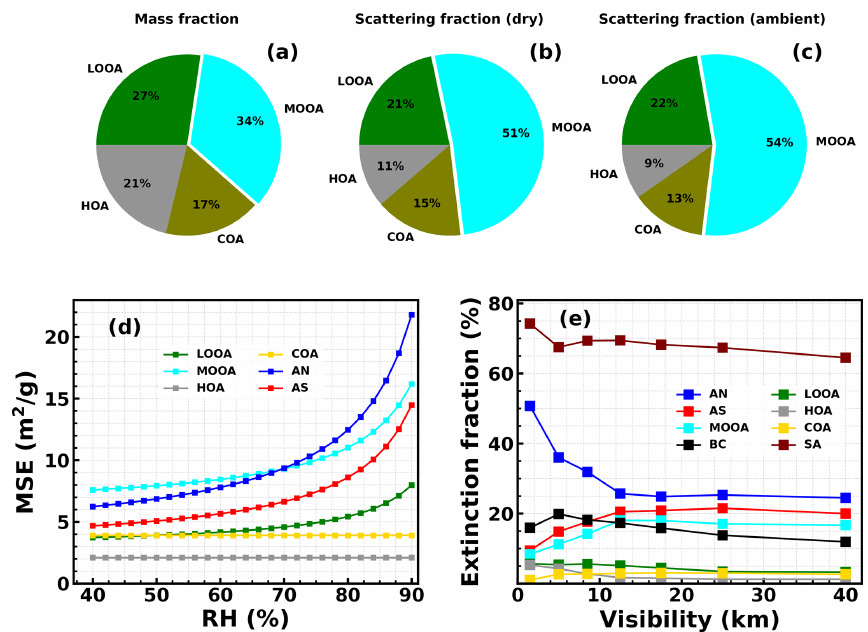
Figure 5. (a) Average mass fractions of organic aerosol components in total organic aerosol. Contributions of different organic aerosol components to total organic aerosol scattering coefficients under dry (b) and ambient (c) conditions for PM 1 . (d) MSEs of aerosol components under different RH conditions. (e) Contributions of different aerosol components to visibility degradation under different visibility conditions. SA corresponds to summation of secondary aerosol